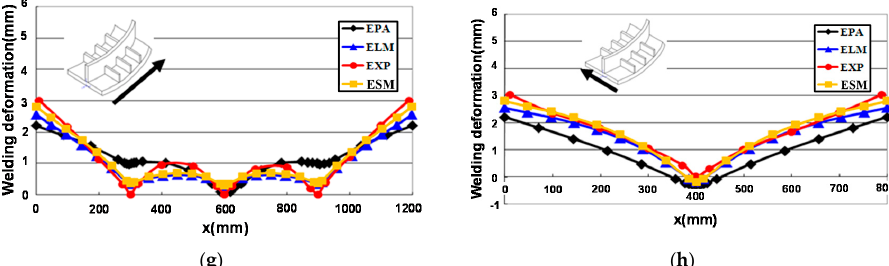
Figure 12. Comparison of welding deformations between experiment and analysis: ( a ) longitudinal direction (CASE 1), ( b ) transversal direction (CASE 1), ( c ) longitudinal direction (CASE 4), ( d ) transversal direction (CASE 4), ( e ) longitudinal direction (CASE 2), ( f ) transversal direction (CASE 2), ( g ) longitudinal direction (CASE 3), ( h ) transversal direction (CASE 3). EXP: experimental result; EPA: elasto-plastic analysis; ELM: equivalent load method; ESM: equivalent strain method.